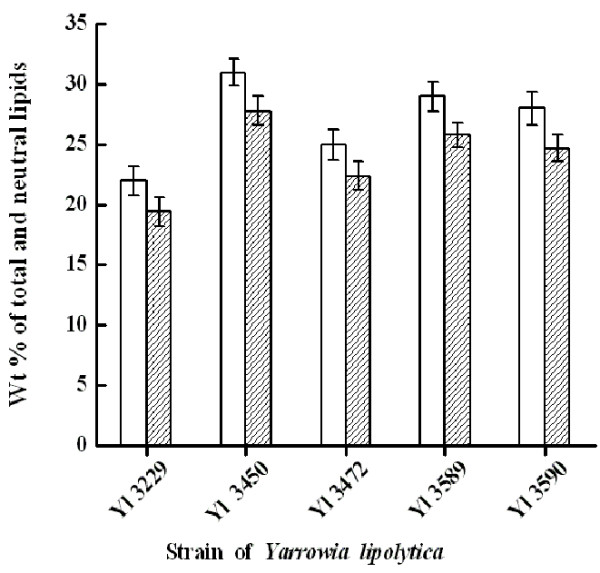
Neutral lipid content of different strains of Y. lipolytica. The data are expressed as mean ± standard deviation (n = 3). Mean values for total lipid and neutral lipid content (wt %) were determined as mentioned in Materials and Methods and did not differ significantly (p < 0.05). Bar (empty): Total Lipids (wt %)and Bar (oblique line): Neutral lipids (wt %).